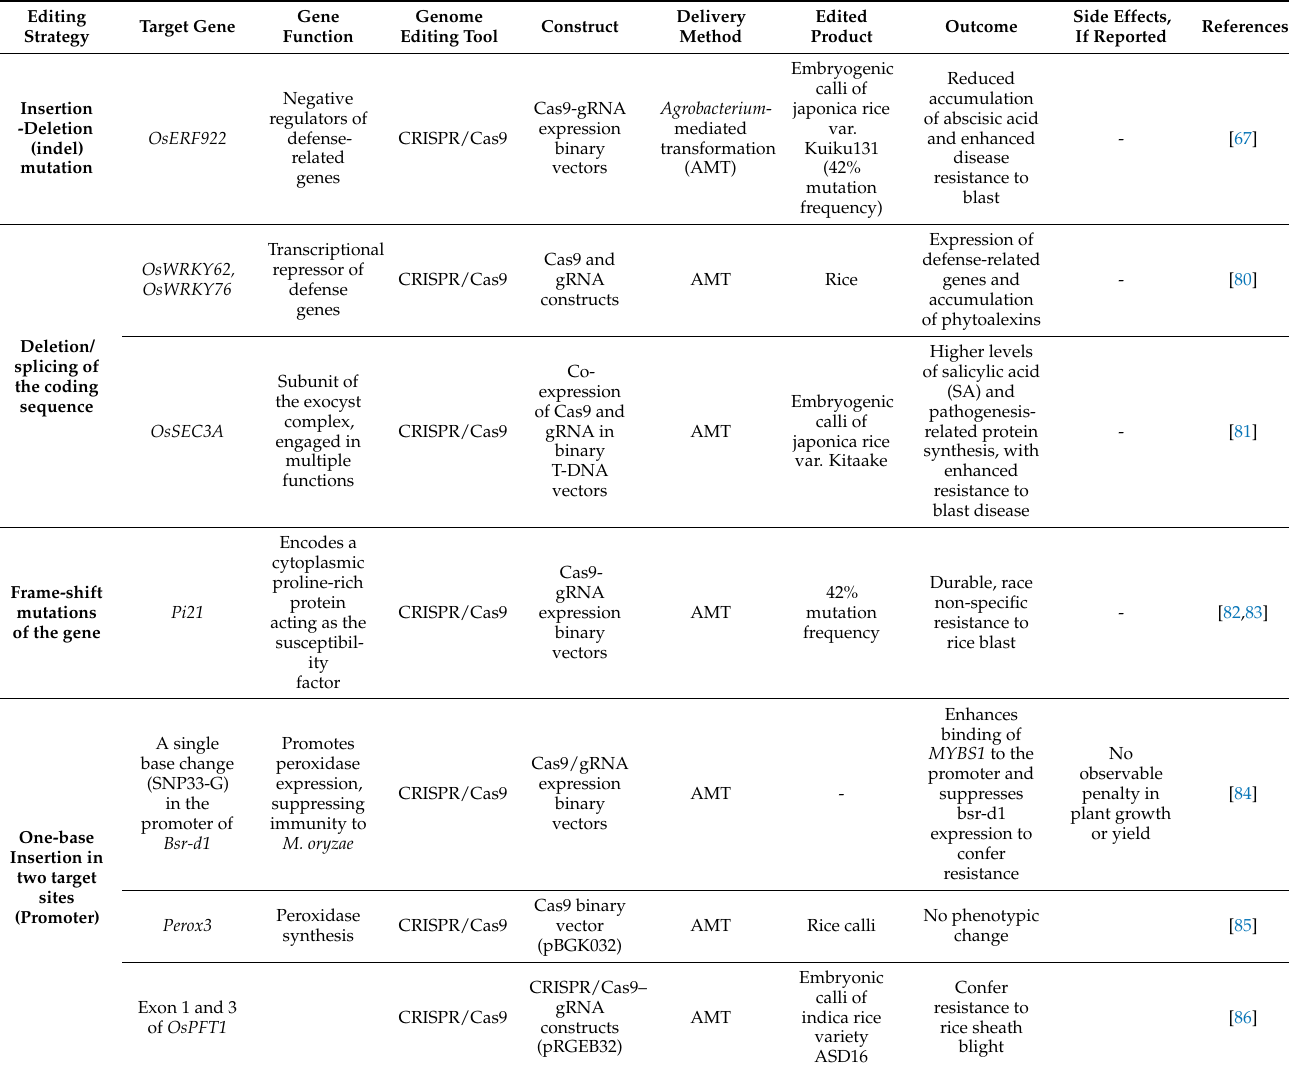
Table 2. Application of genome editing tools for fungal disease resistance in